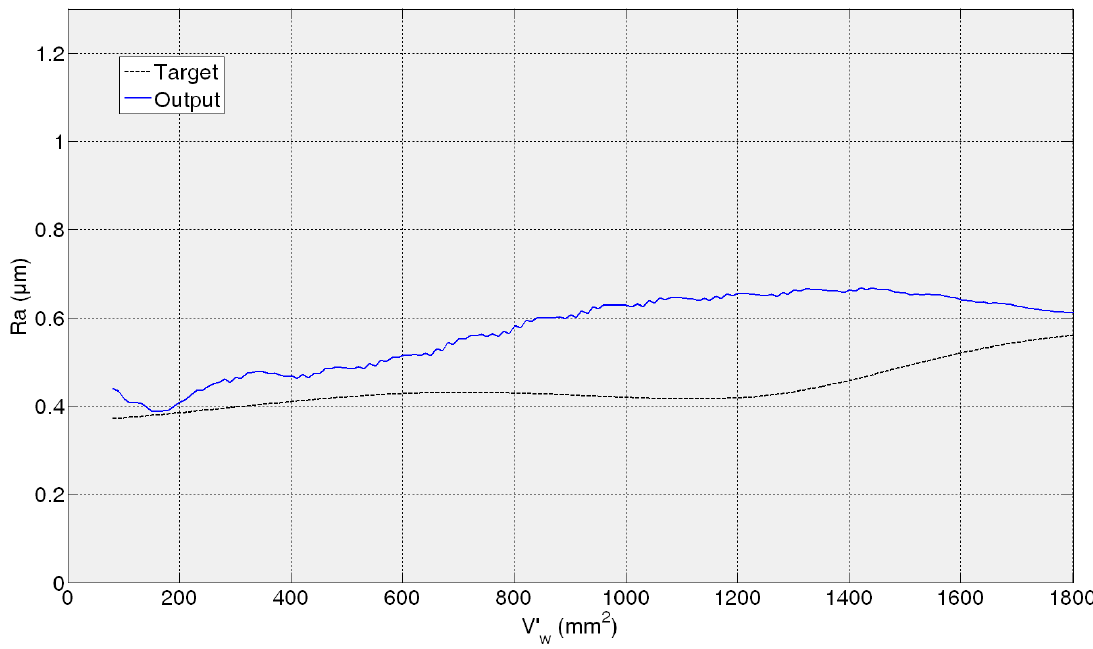
Figure 12. R measurement for 82AA70G6VW wheel, q a process